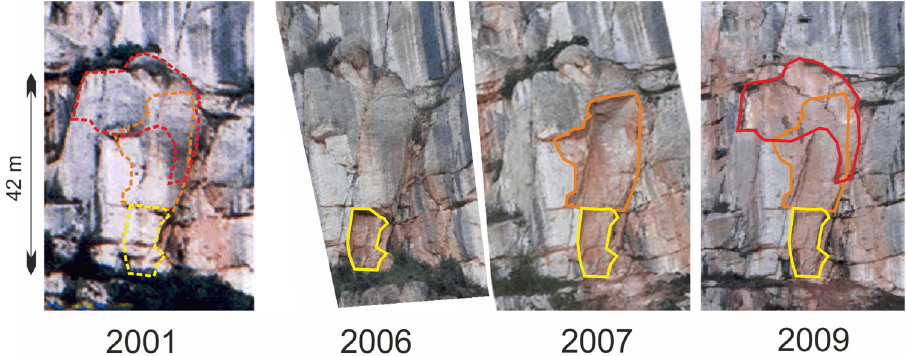
Figure 7. Depiction of the large blocks sequence detachment during the 2001–2009 period in Degotalls N cliff. The detachment was controlled by discontinuities produced by fractures and stratigraphic layers. In the 2001 image: Degotalls area before the rockfall (in dashed lines). In 2008, the surface of the cliff stabilized after different rockfalls episodes, resulting in a total rockfall volume higher than 1000 m 3 . Data collection and processing.